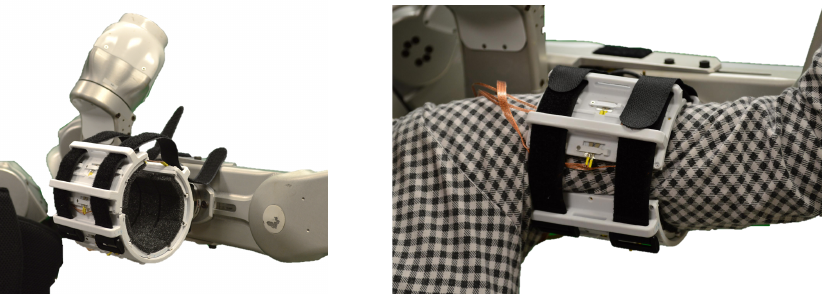
Figure 5. The sensorized upper-arm cuff is used with the upper-body Harmony exoskeleton and a human user to explore potential applications of this